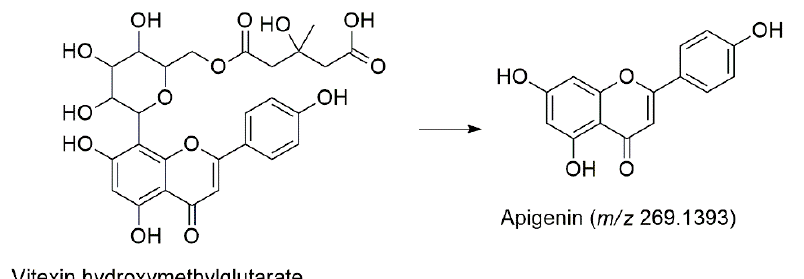
Figure 5. The fragmentation pathways of the apigenin derivatives.